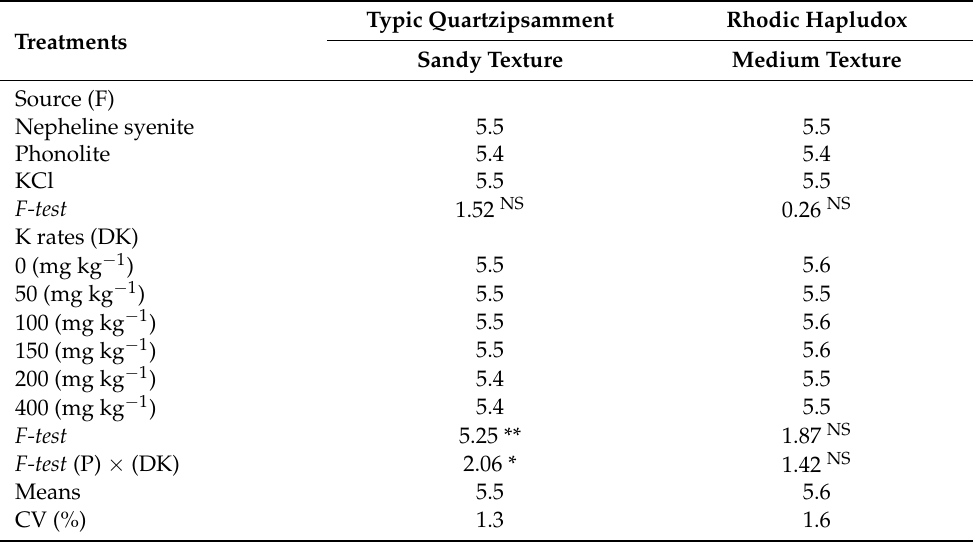
Table 2. pH values (CaCl2) obtained after 30 days of incubation and before sowing the maize crop according to the treatments